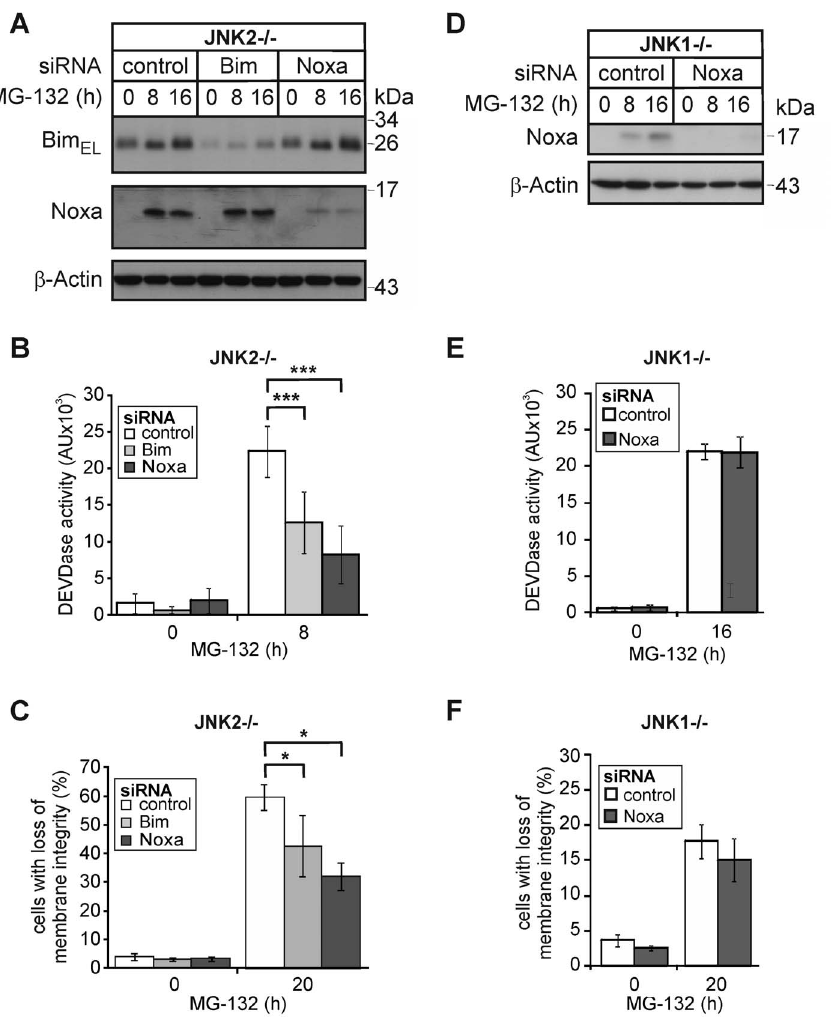
Figure 3. Knockdown of Noxa protects JNK2 2 / 2 cells, but not JNK1 2 / 2 cells from MG-132-induced apoptosis. ( A , D ) Western blots showing the status of BimEL, Noxa and b -actin in JNK2 2 / 2 and JNK1 2 / 2 cells that were either left untreated or exposed for the indicated times to MG-132 72 hours post transfection with control, Noxa or Bim siRNAs. One representative experiment out of five and three is shown, respectively. Please note that the autoradiograph in D was overexposed in order to detect trace amounts of Noxa in JNK1 2 / 2 cells. ( B , E ) Fluorometric determination of caspase-3 (DEVDase) activities in JNK2 2 / 2 and JNK1 2 / 2 cells treated as described in A and D , respectively. Please note that DEVDase activities of JNK2 2 / 2 and JNK1 2 / 2 cells were analyzed at different time points (8 h and 16 h) according to their sensitivities. ( C , F ) Cytometric determination of cell death (propidium iodide uptake) in JNK2 2 / 2 and JNK1 2 / 2 cells treated as described in A and D , respectively. Values are the mean of four and three independent experiments, respectively, + / 2 SD. * p , 0.05; *** p , 0.001 according to ANOVA Tukeys test ( B ) or ANOVA on ranks Student-Newman-Keuls-Method ( C ) in an all pairwise multiple comparison as indicated.